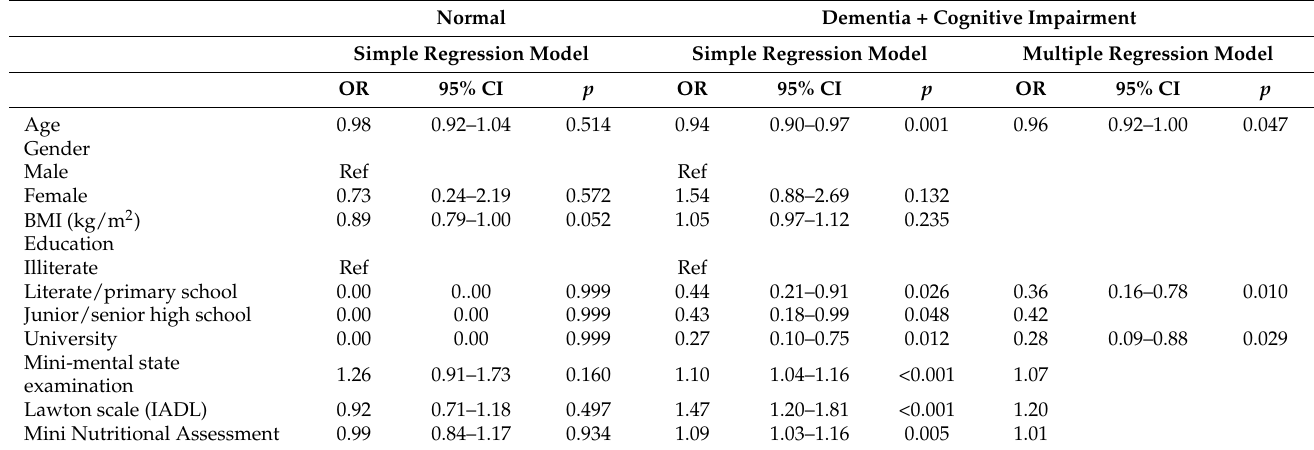
Table 3. Associated factors of dichotomized BI score change (positive vs. non-positive).